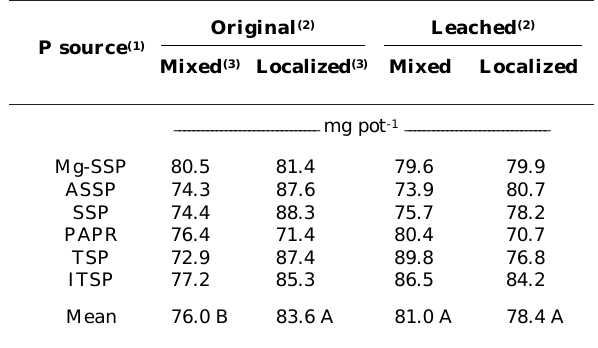
Table 4. Effect of acidulated P fertilizers, application methods and water leaching on the P uptake by three corn crops grown in samples of a Red- Yellow